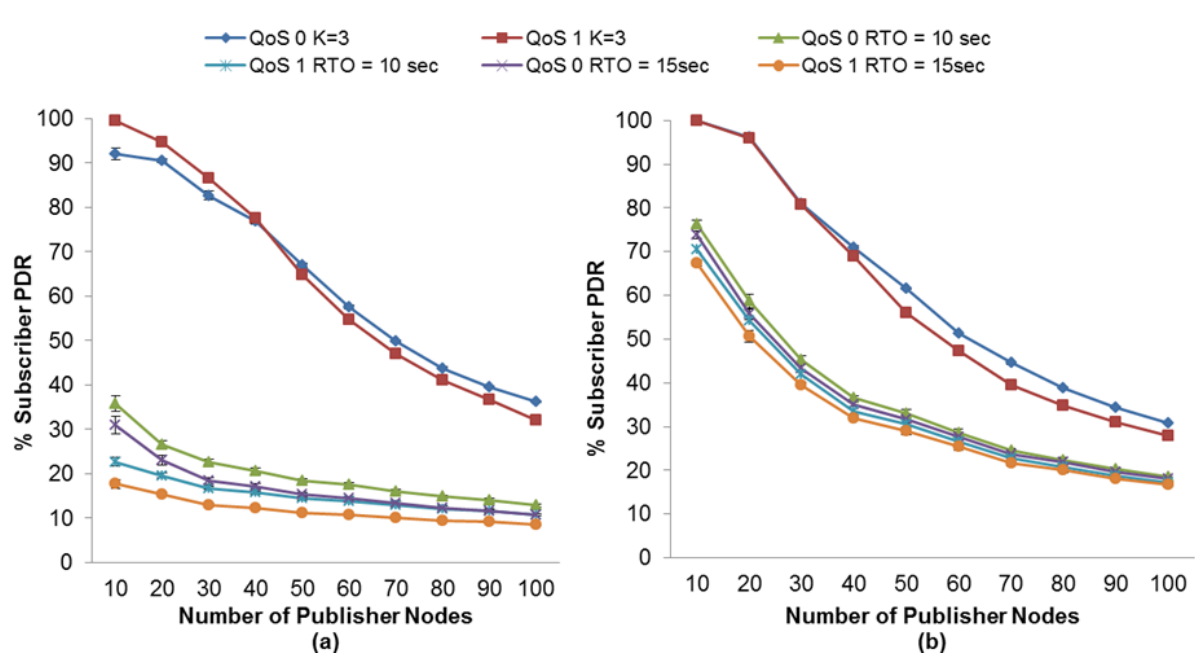
Figure 6. PDR comparison between the RTO method of MQTT-S calculation and our proposal without ( a ) and with ( b ) MAC